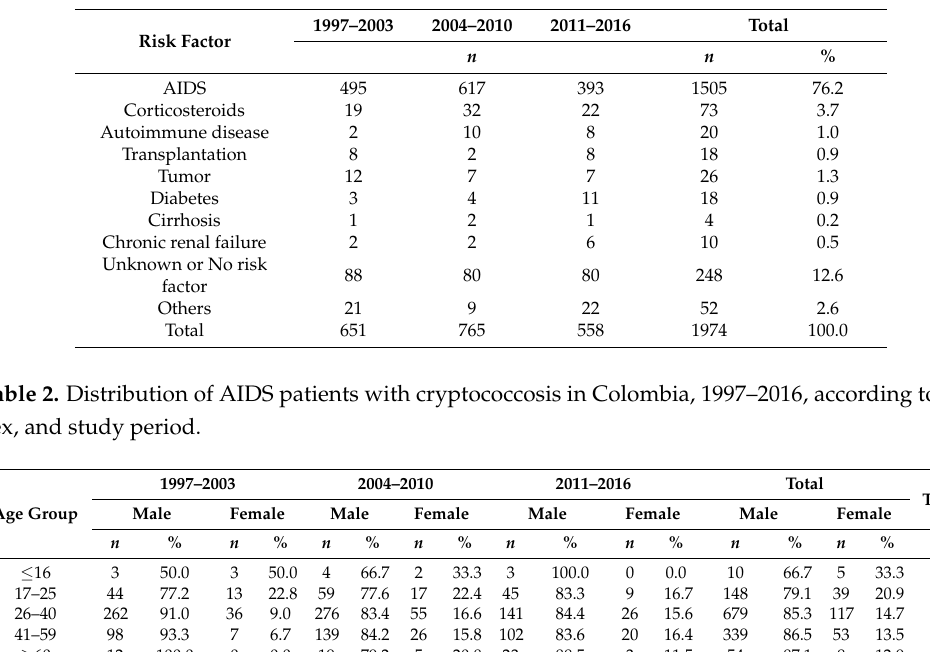
Table 1. Risk factors associated with cryptococcosis cases in Colombia, 1997–2016. Comparison between study periods.